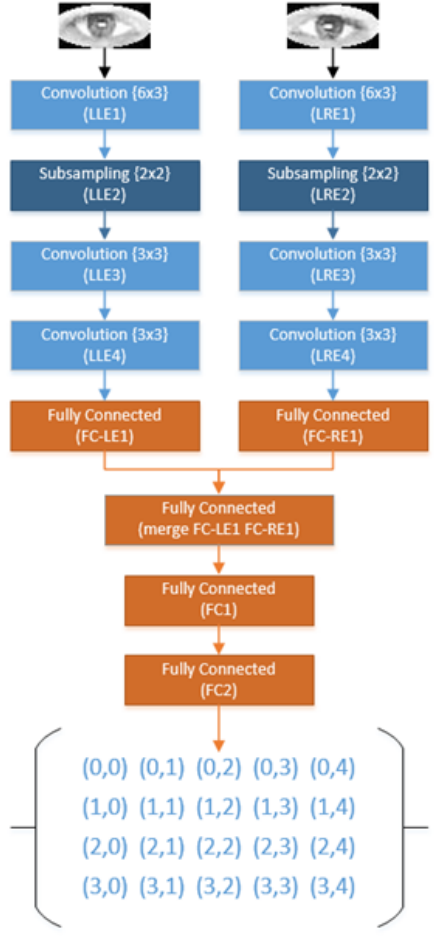
Figure 7. Network architecture for the network using both eyes